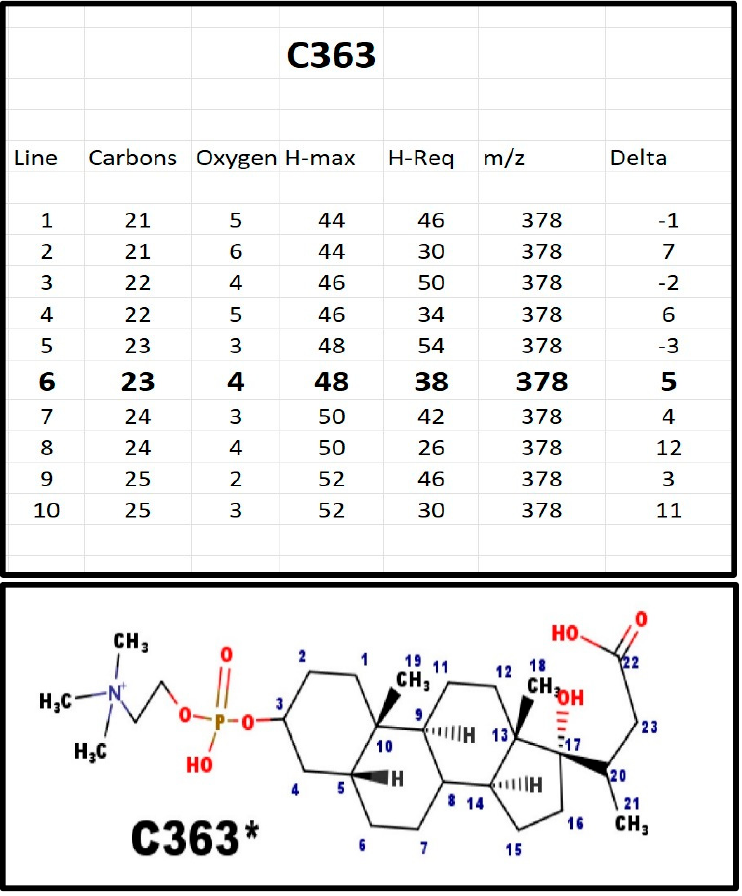
Figure A7. The proposed structures of C363.